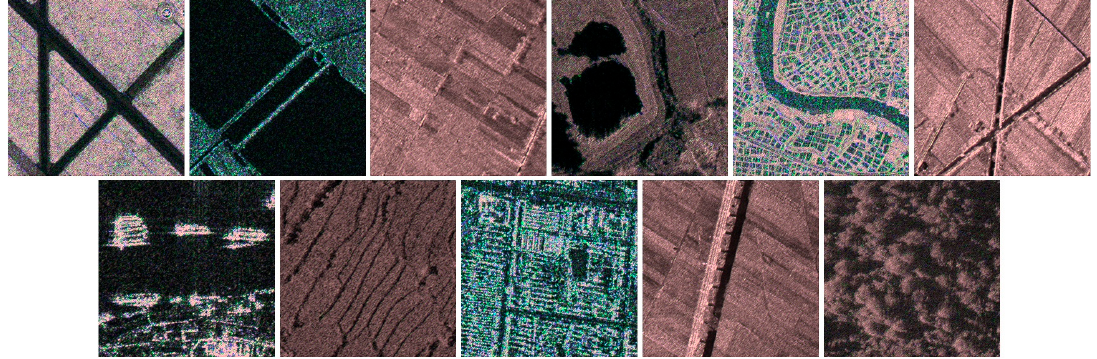
Figure 7. The fusion map of two Gabor features for the 11 types of scenes.